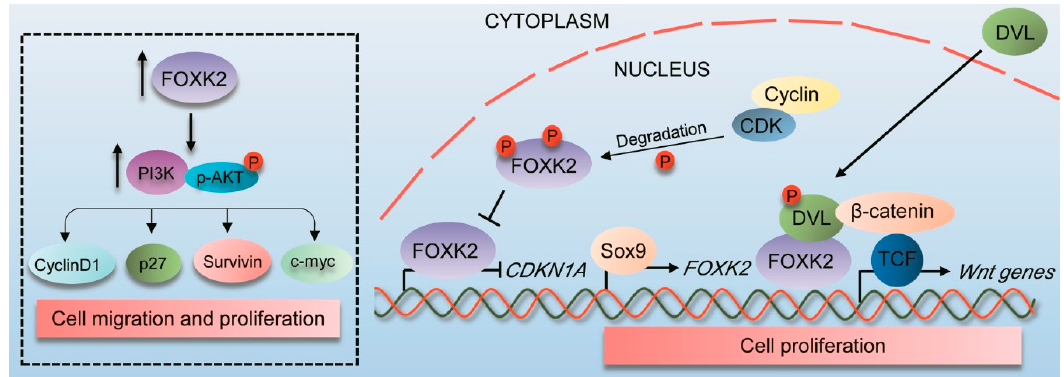
Figure 4. FOXK2 role as an oncogene in cancer. FOXK2 is transcriptionally regulated by the Sox9 oncogene and promotes proliferation of colorectal cancer cell lines. In this context, FOXK2 interacts with DVL, translocating it to the nucleus, and then promoting Wnt/ β -catenin signaling pathway. In agreement, FOXK2 overexpression promotes cell migration and proliferation in hepatocellular carcinoma, which is associated with high levels of Survivin, c-Myc, p27, cyclin D1 and phosphorylated AKT protein expression. A role in cell cycle progression has also been attributed to FOXK2, which is phosphorylated by CDK-cyclin complexes in a cell cycle dependent manner, in a process that induces its degradation and impairs its transcriptional activity following cell division. Box represents associations between FOXK2 and other molecules in studies involving overexpression and inhibition of